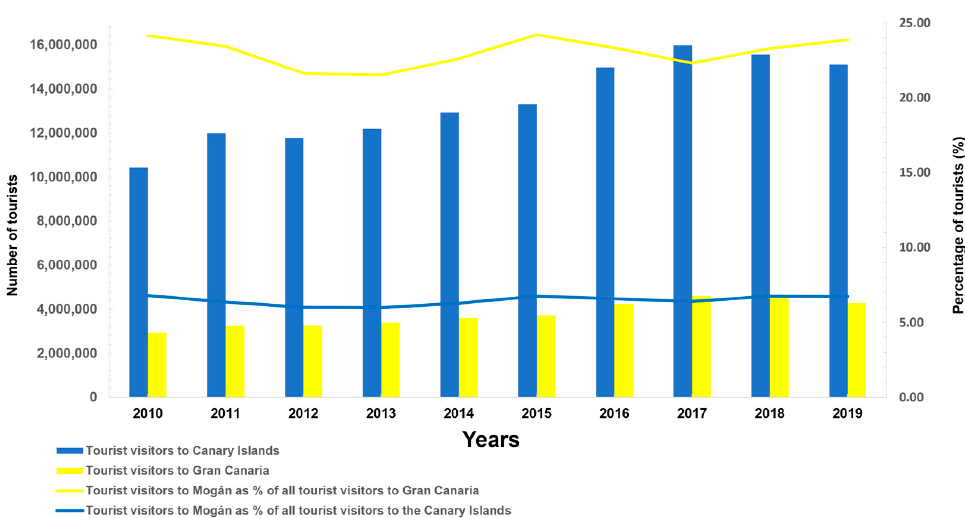
Figure 1. Tourist visits to the Canary Islands, Gran Canaria, and Mogán over a 10-year period (2010–2019).